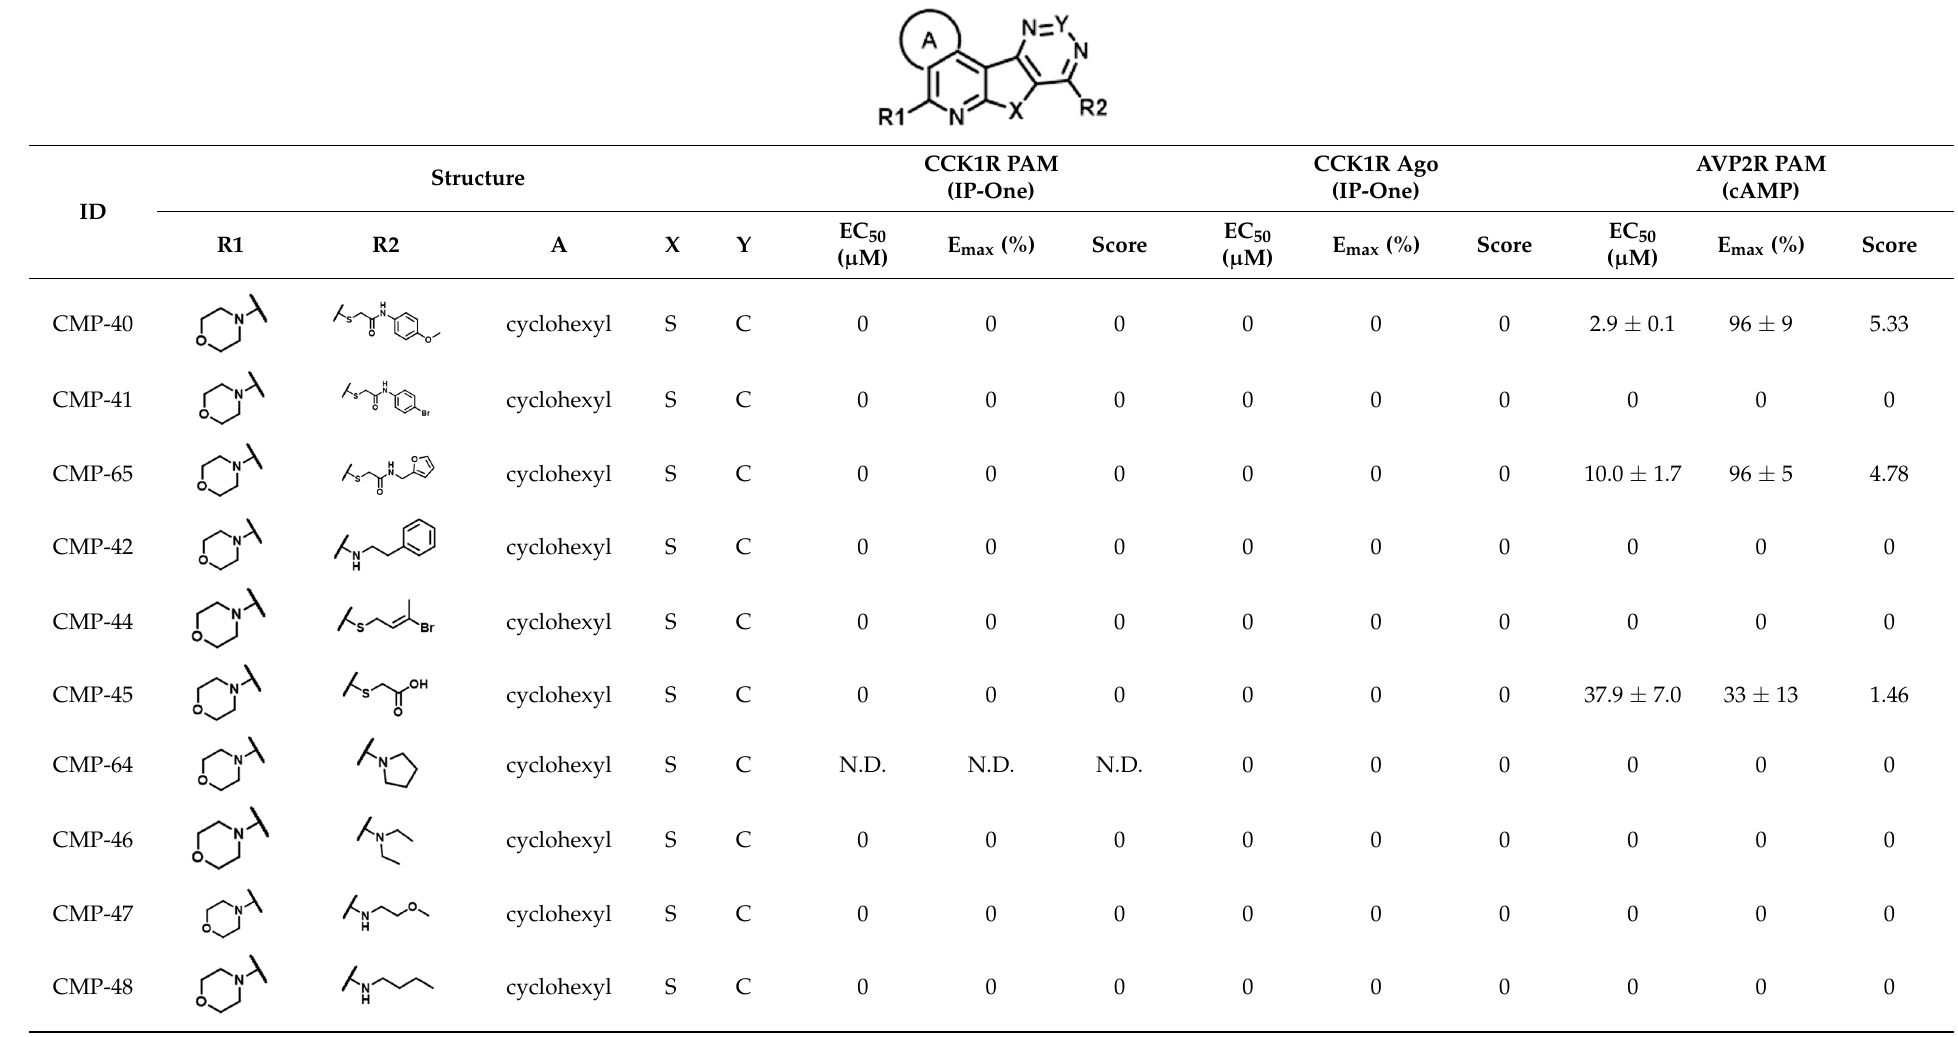
Table 4. Structure–activity studies of 15 morpholine analogs with non-basic amine R2 substitutions.